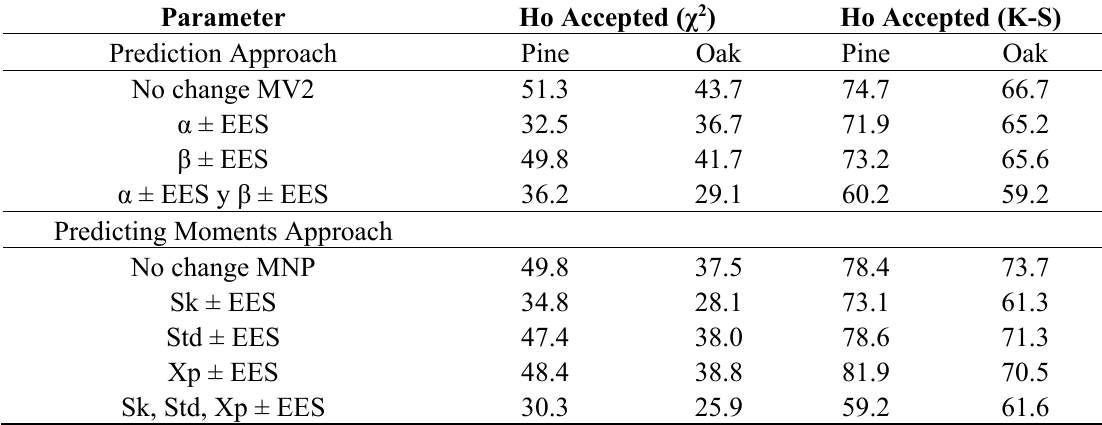
Table 5. Sensitivity analysis of equations for predicting and recovering the Weibull distribution parameters, and the goodness-of-fit test for pine and oak stands of Durango,